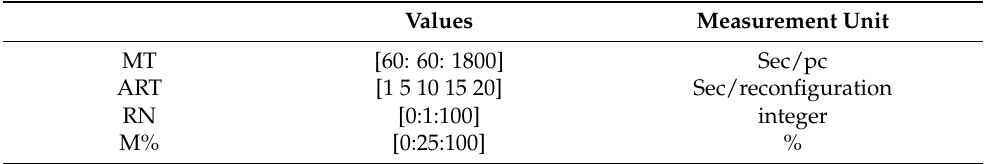
Table 7. Range of variation of the input